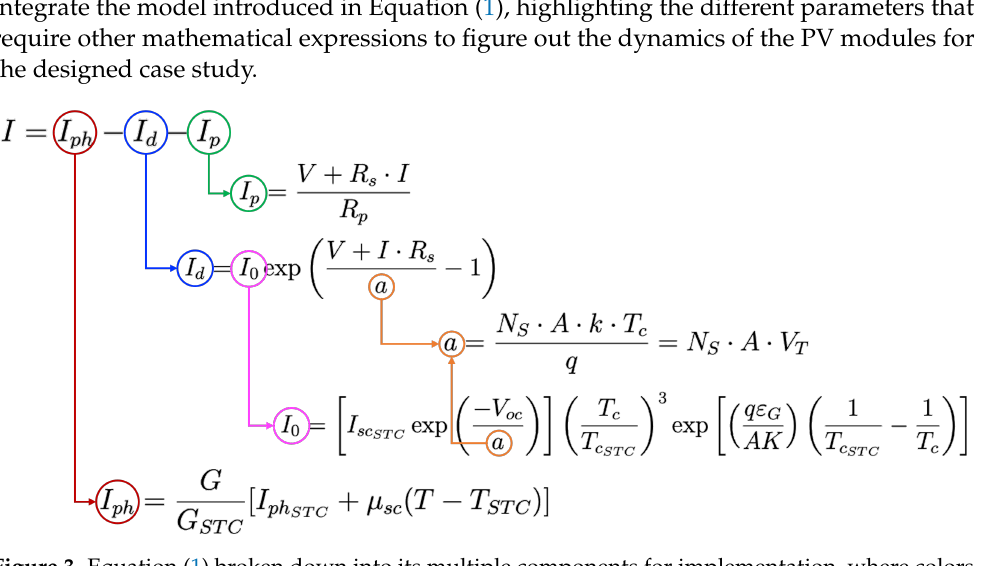
Figure 3. Equation (1) broken down into its multiple components for implementation, where colors are used to address how each variable is estimated through time and where they are